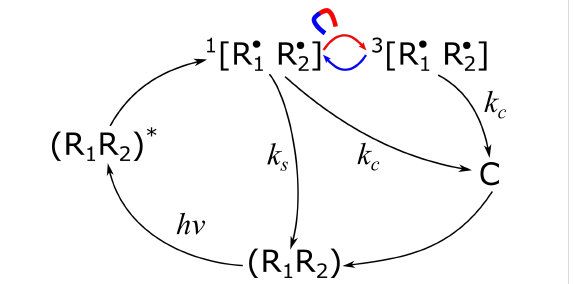
Figure 5: Formation of MFEs upon recombination of SCRPs. In this example the (R 1 R 2 ) molecule goes to the singlet excited state (R 1 R 2 ) * ; subsequently, the SCRP [R 1• R 2• ] is formed in the singlet state. The singlet-state SCRP can recombine to the ground state or go to the triplet state by interconversion: this stage is magneto-sensitive as symbolically indicated. Both singlet and triplet SCRP can go to the state C, e.g., SCRP can undergo diffusional separation to form escaped radicals. Typically, the interconversion is slower at higher fields, i.e., formation of (R 1 R 2 ) is more efficient at high fields. For the triplet precursor the MFE is the opposite: formation of (R 1 R 2 ) is less efficient at high fields. The same scheme can be used to explain MIE: the interconversion rate depends on the content of magnetic isotopes in radicals. The interconversion rate is, e.g., higher for 13 C enriched radicals. One should note the similarities with Figure 1: (R 1 R 2 ) * corre- sponds to (singlet) exciton in neat material; 1 [R 1• R 2• ] and 3 [R 1• R 2• ] cor- respond to CTS; (R 1 R 2 ) = ground state; C = charge separated state